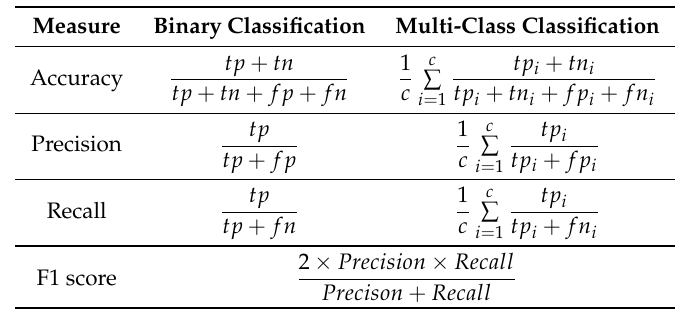
Table 5. Classification performance measures.